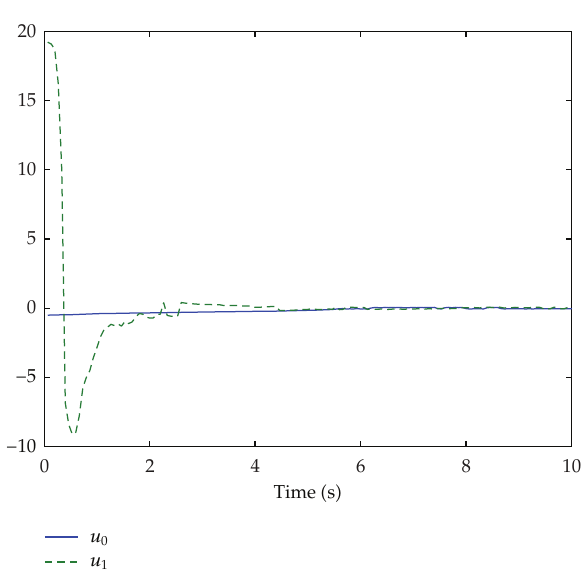
Figure 2: Time history of control